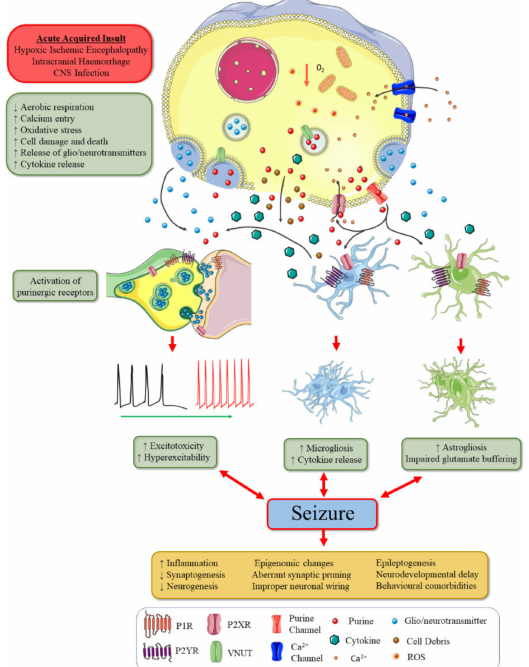
Figure 2. Cellular mechanisms of acute symptomatic neonatal seizure ictogenesis and the potential role of purinergic signalling: following an acute insult to the neonatal brain, cells are placed under high cellular stress, leading to increases in calcium entry and cell death pathways. In the case of hypoxic-ischemic encephalopathy (HIE)-induced seizures, the lack of oxygen and glucoses limits aerobic respiration, forming radical oxygen species (ROS) causing further oxidative stress on cells. Increases in intracellular calcium and cell death can trigger the release of glio / neurotransmitters (e.g., glutamate) into the extracellular space that increases neurotransmission. Cell debris can trigger microgliosis, astrogliosis and release of proconvulsive cytokines. Purines (e.g., ATP and adenosine) are also hypothesised to be released into the extracellular space following cell death and through a combination of exocytotic and non-exocytotic mechanisms under cellular stress. ATP acts upon P2X7 to further increase intracellular calcium, contributing to cell death mechanisms and to increasing neurotransmission and, in turn, seizure severity. P2X7 activation is known to potentiate proconvulsive cytokine release following neonatal seizures, which in turn can lower seizure thresholds. Other P2 receptors are known to modulate many mechanisms of seizure ictogenesis, such as direct modulation of neurotransmission and inflammatory signalling cascades. A2 A receptors may also contribute to neonatal seizures via similar mechanism to P2X7. Conversely, A1 receptor activation is anticonvulsive in neonatal seizures, acting as an endogenous compensatory mechanism. Once these outlined mechanisms create a system that favours excitatory neurotransmission, seizures are elicited. A seizure can also create further cellular stress and neuroinflammation, increasing the likelihood of recurrent seizures. Elevated